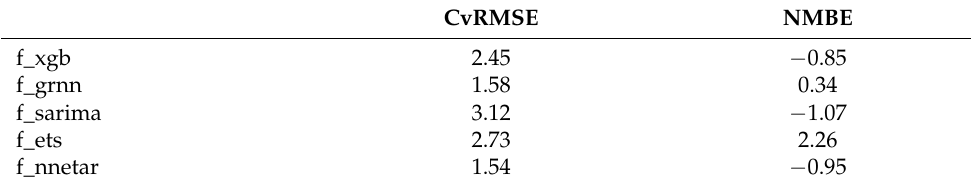
Table A6. Weekly forecast error measure (in